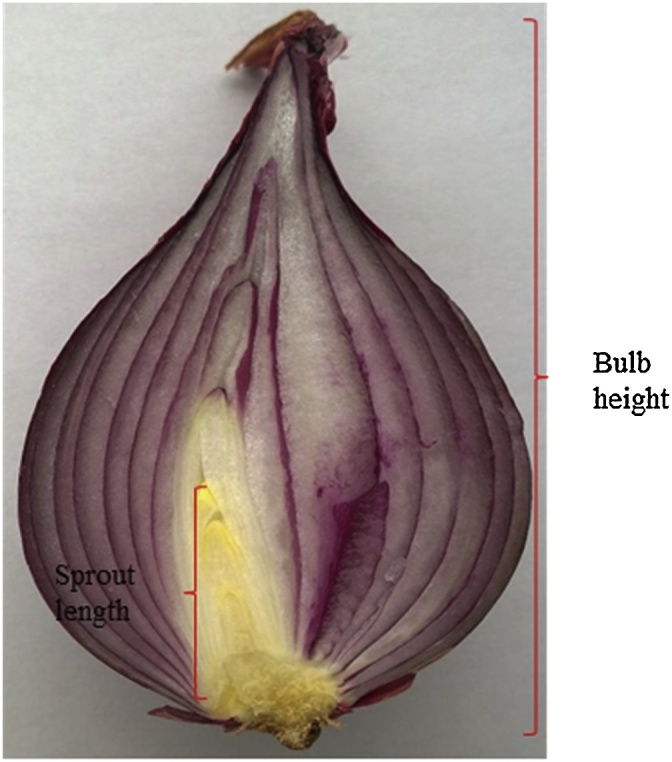
Depiction of sprout assessment.